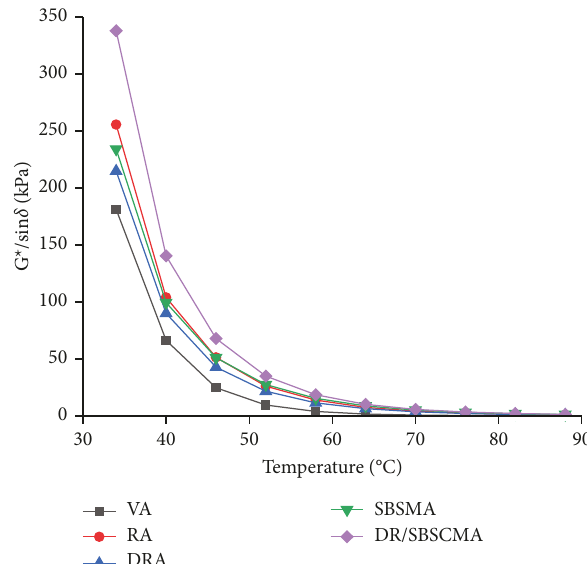
Figure 8: Test results of the rutting